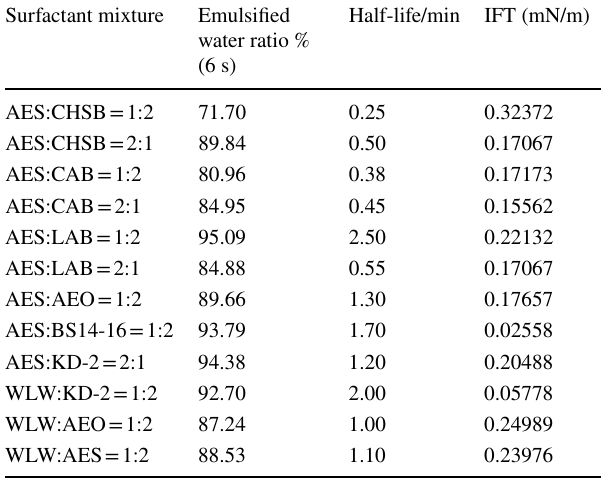
Table 3 Emulsification test and IFT measurements results of different surfactant mixtures Surfactant